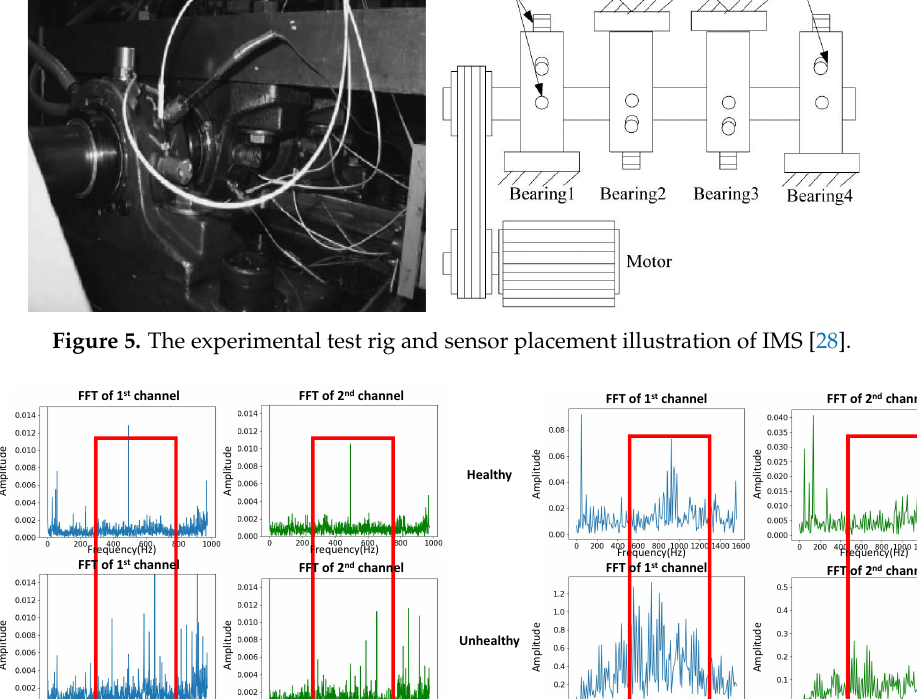
Figure 6. Spectral density difference in bandwidths through fast Fourier transform, ( a ) Intelligent Maintenance Systems (IMS), ( b ) Fanche-Comte Electronics Mechanics Thermal Science and Optics—Sciences and Technologies Institute